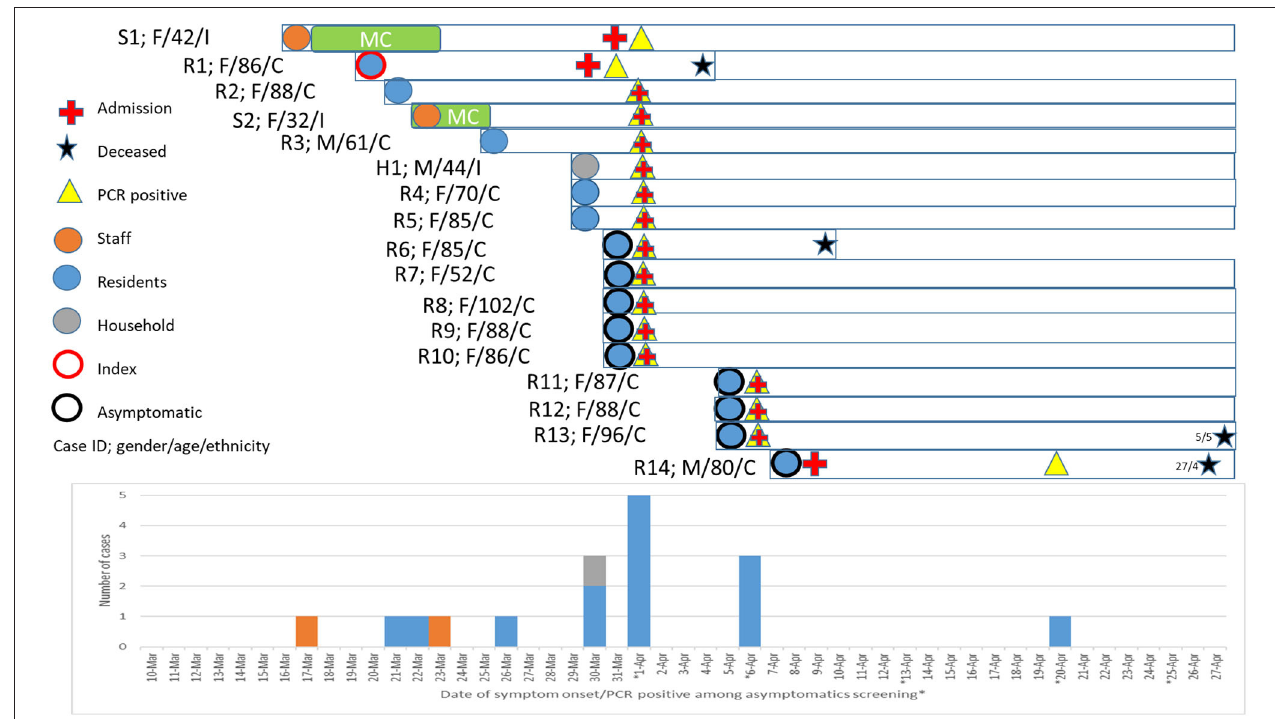
FIGURE 2 | Epicurve and characteristics of coronavirus disease 2019 (COVID-19) cases. Epicurve was charted based on the onset of symptoms and swab positive notification from the serial point-prevalence survey. Gender, age, ethnicity (C, Chinese; M, Malay; and I, Indian), symptomatic status, date of PCR test, admission, and fatality were highlighted. The index and primary cases of the nursing home outbreak are R1 and S1, respectively. H1 is the household member of